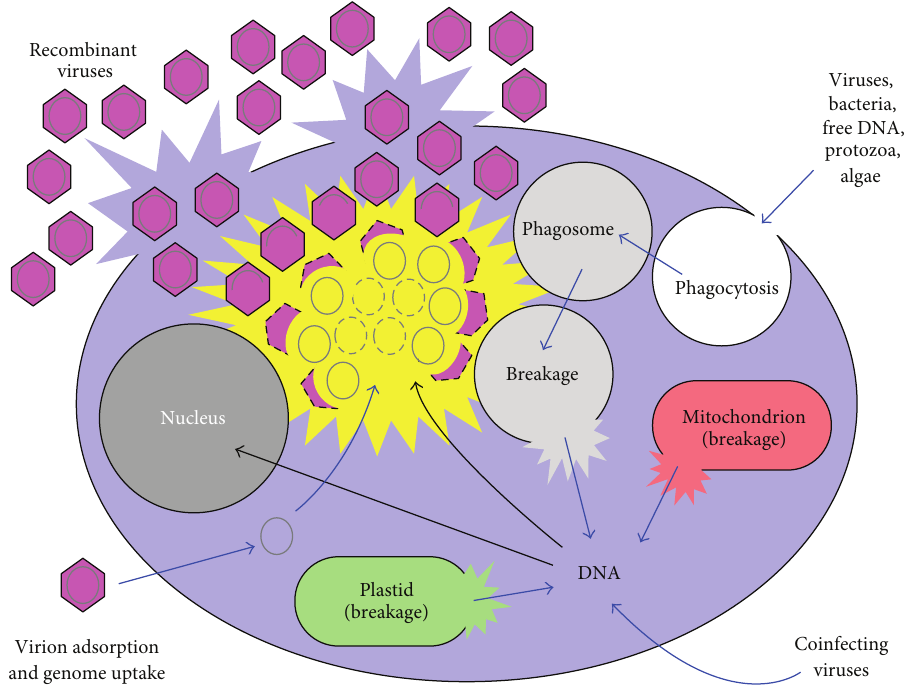
F 4: Summary of sources of DNA available for recombination by viruses of various protists. Any DNA that is able to �nd its way into a cell’s cytoplasm, even accidentally, has a potential to become incorporated into preexisting DNA found within that cell, either as associated with the cell nucleus or with the virion factory structure (yellow) of infecting DNA viruses [62, 69, 71]. is illustration is also an elaboration on the “You are what you eat” hypothesis of Ford Doolittle [75] as elaborated further upon also by Andersson [76], Keeling and Palmer [77], and Abedon